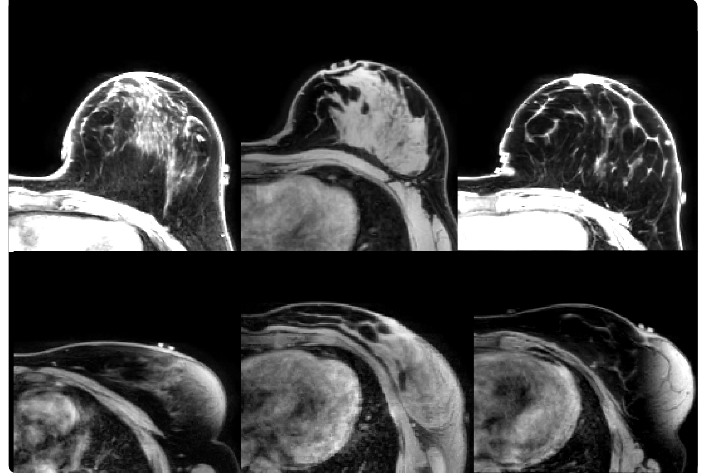
Figure 2. From ( left ) to ( right ): Cases A1, A2, A3 and A4 (from prone-supine Group A). ( Upper ) row: source image acquired in prone orientation. ( Lower ) row: target image acquired in supine orientation.